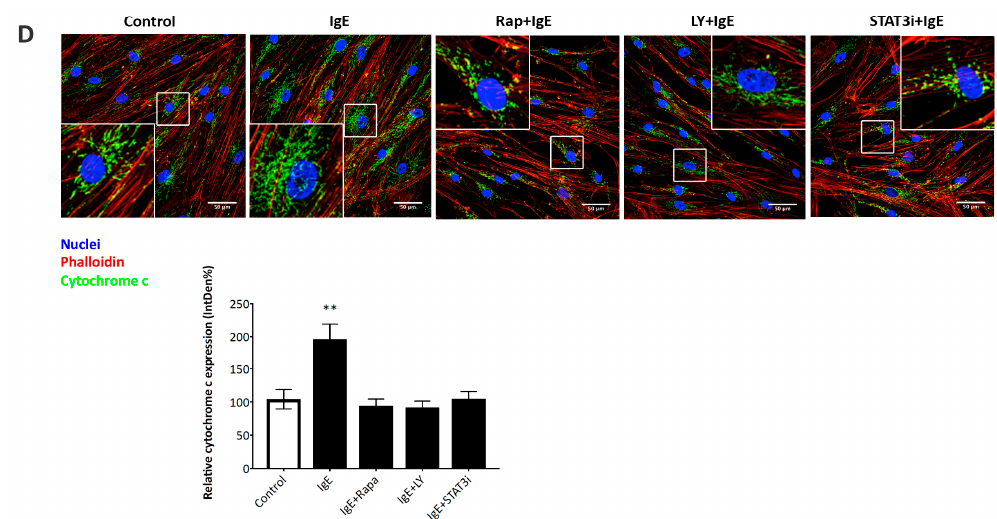
Figure 5. Signaling inhibitors blocked IgE-induced P70S6K and mitochondria activation. ( A ) Representative Western blot of the kinetic of IgE-induced phosphorylation of P70S6K, which was blocked by signaling inhibitors for rapamycin (Rap), LY294002 (LY), and S3I-201 (STAT3i). Left panel shows the quantitative analysis Western blots by Image J. Bars represent mean ± SEM P70S6K expression form ASMC of five asthma patients * p < 0.05, ** p < 0.01, *** p < 0.001. ( B ) Signal inhibitors reduce collagen-I and fibronectin deposition by ASMC after 24 h, as determined by ELISA. Bars represent mean ± SEM of quadruplicate measurements in ASMC five asthma patients. The “control” depicts deposition in the absence of IgE. * p < 0.05. ( C ) ASMC migration was assessed by measuring the width of a “wound” in a confluent ASMC layer after 24 h. Bars represent mean ± SEM of independent experiments performed in ASMC of five asthma patients. The “control” depicts migration in the absence of IgE. * p < 0.05. ( D ) Representative immunofluorescence images of IgE-induced cytochrome c expression (green) in the presence and absence of signaling inhibitors after 24 h (600X magnification in enlarged boxes). Image analysis of 10 single cells in five individual ASMC lines ( n = 50) is presented as the bar chart of the mean ± SEM. ** p <